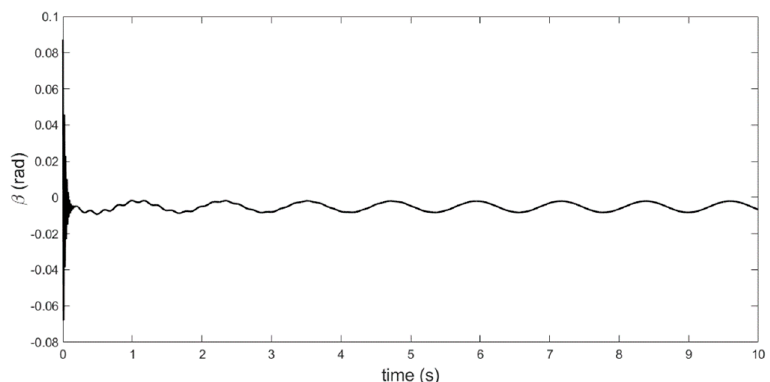
Figure 9. Time response of beta in flutter speed (23.9 m/s).